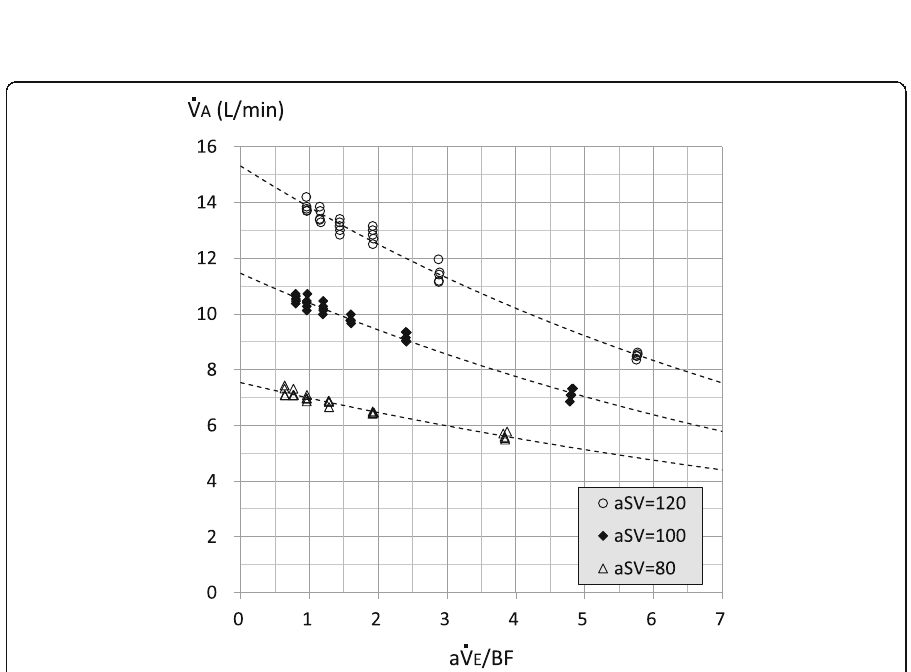
Fig. 8 Relationship between actual minute volume divided by bias flow (a _ VE/BF) and alveolar ventilation ( _ VA). Legend: Dotted curves are the exponential approximations. The coefficient of correlations ( R ) and P values are as follows: aSV=80: R = − 0.982, P <0.001; SV=100: R = − 0.991, P <0.001; and aSV=120: R = − 0.992, P <0.001. The Y -intercepts are 7.54 (aSV=80), 11.46 (aSV=100), and 15.31